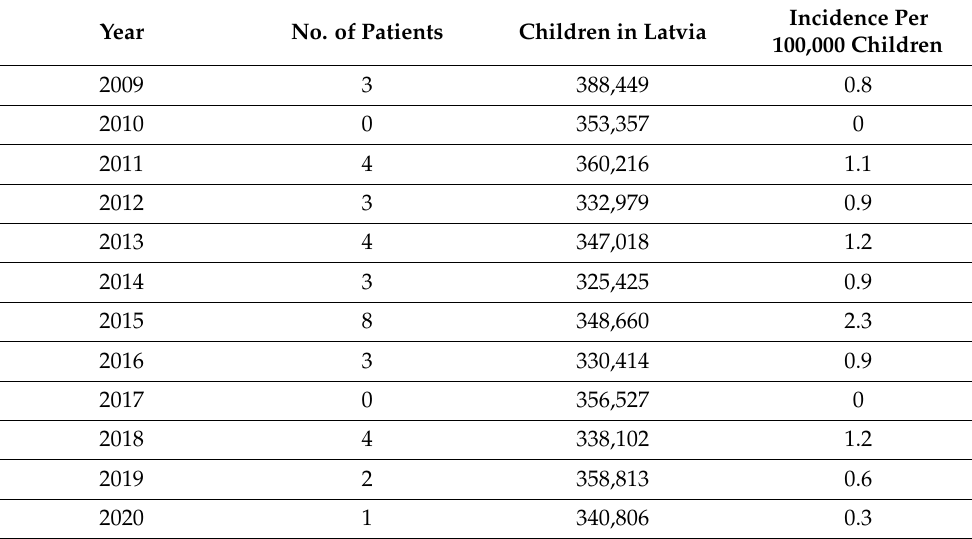
Table 1. The mean annual incidence of sJIA in Latvia. Year No. of Patients Children in Latvia